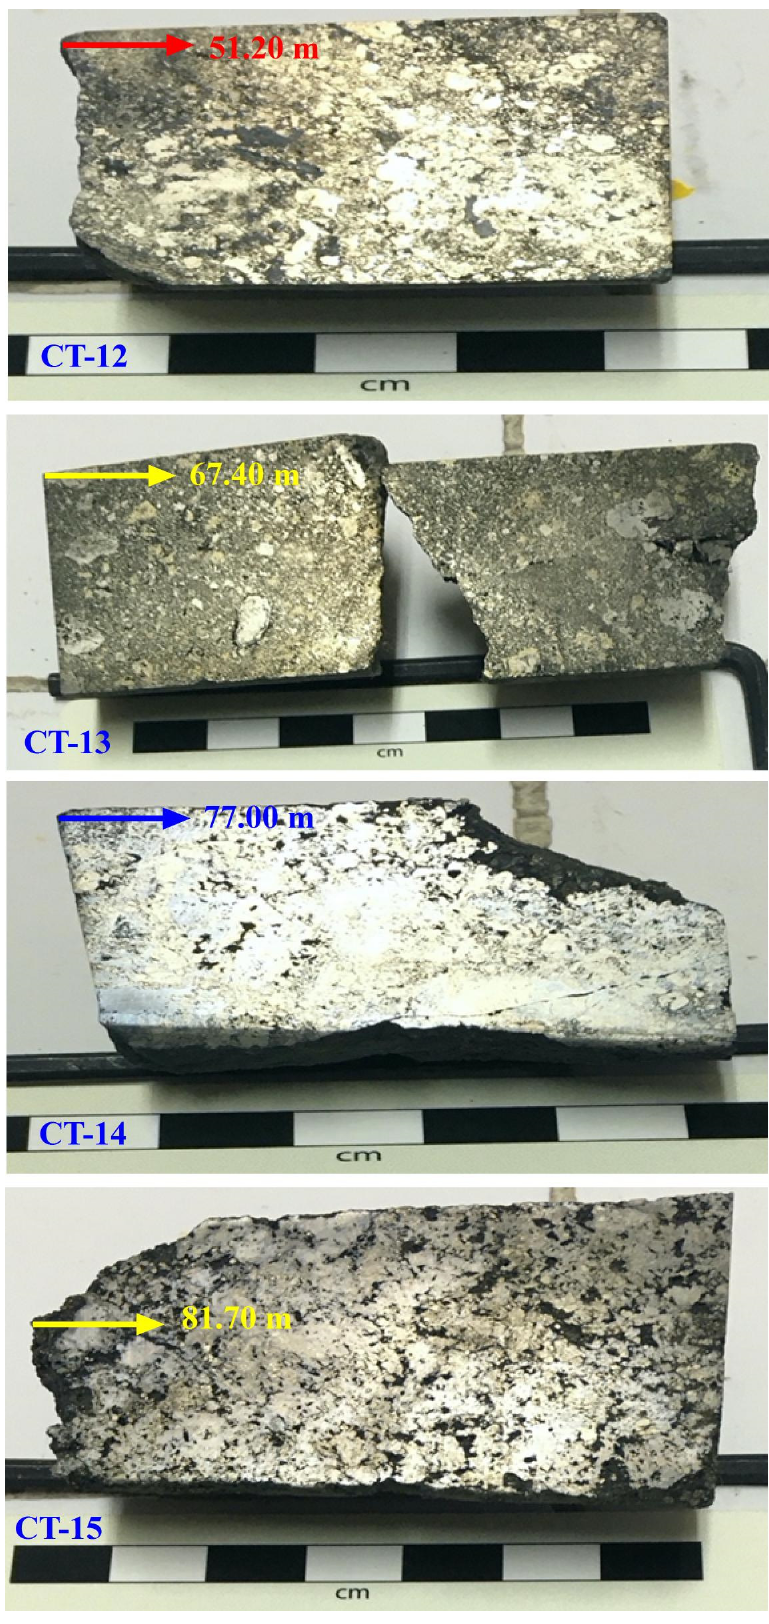
Figure 9. Close-up view of polished well log samples from Cerattepe VMSD, Drill core # CTD-117 at 1645